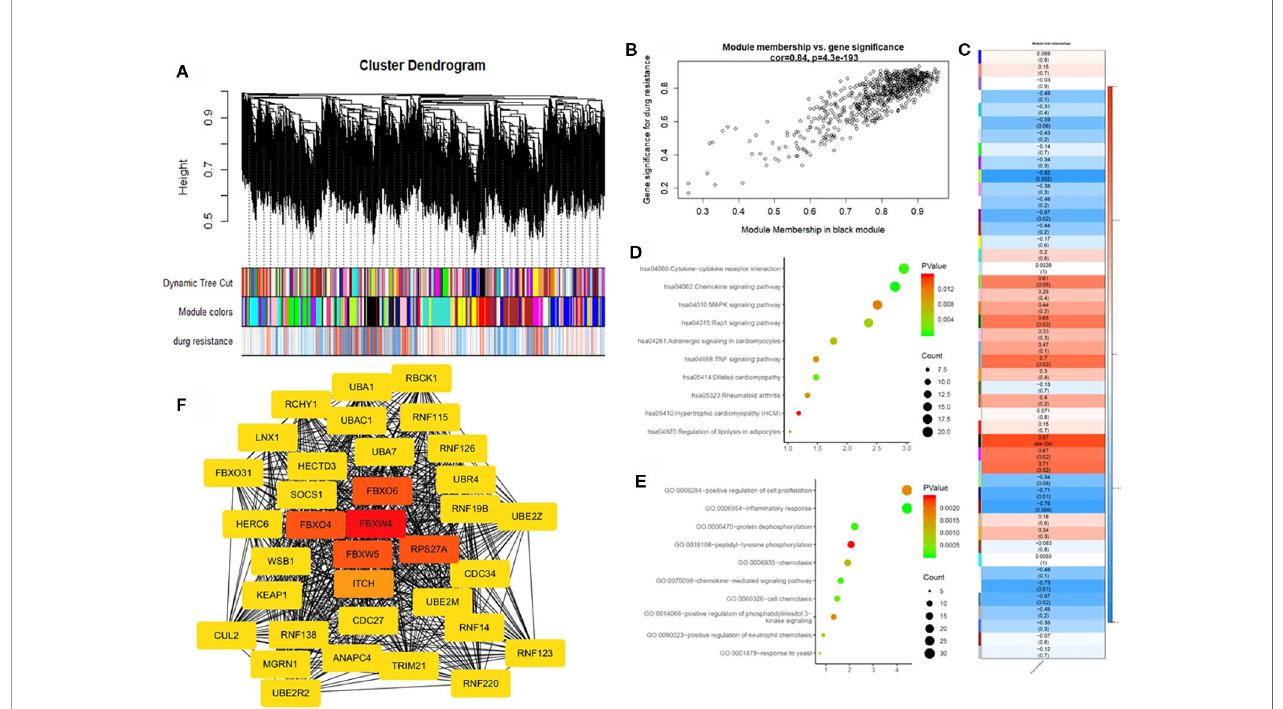
FIGURE 3 | Weighted gene co-expression network analysis (WGCNA) and hub gene screened. (A) Dendrogram of all expressed genes in the top 25% of variance clustered based on a dissimilarity measure (1 − TOM). (B) Scatter plot of the correlation between the black module and chemotherapy resistance. (C) Heatmap of the correlation between module eigengenes and chemotherapy resistance. (D) KEGG pathway analysis of the top ten pathways of genes in black modules. (E) GO functional analysis of the top 10 pathways of genes in black modules. (F) Protein-protein interaction network of genes which has the highest score in the MOCDE in the black module. The color intensity in each node was proportional to the degree of connectivity in the weighted gene co-expression